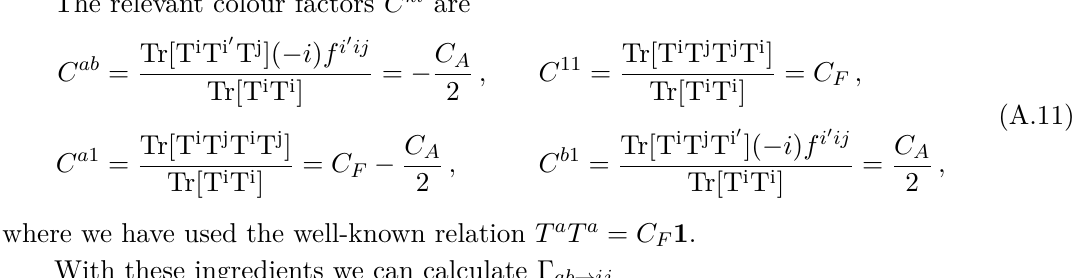
Figure 8. Eikonal diagrams for the soft anomalous dimension in squark-electroweakino production. where t and u are the usual Mandelstam variables. The remaining quantity L one in the limit ( v · n ) 2 → 2 m 2 n 2 /s 1 ˜ q